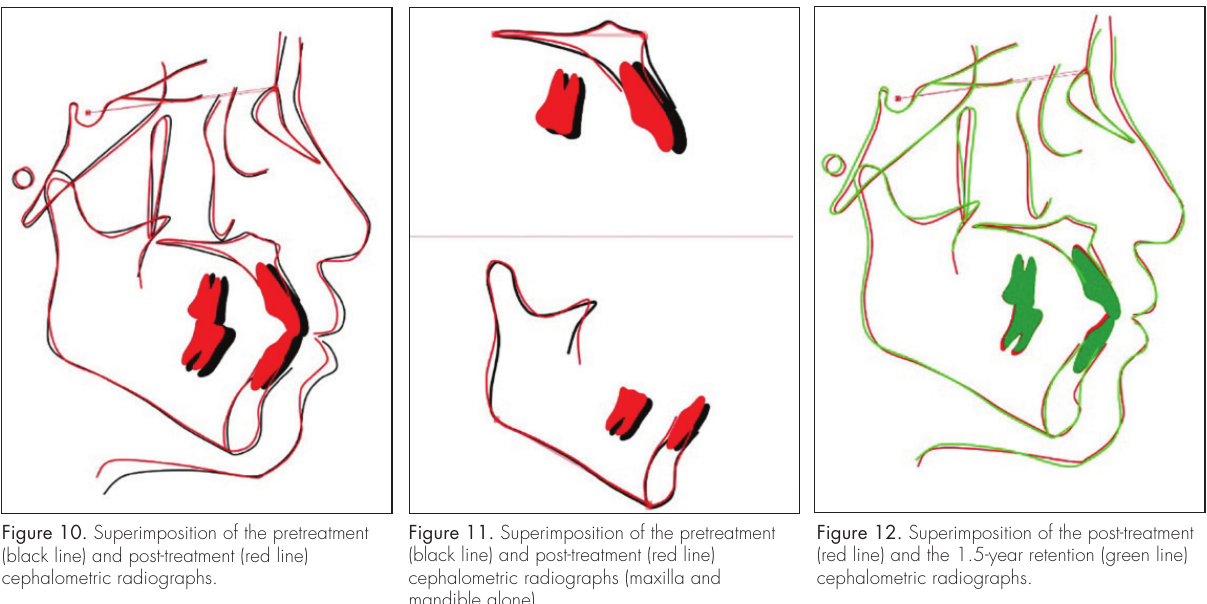
Figure 10. Superimposition of the pretreatment (black line) and post-treatment (red line) cephalometric radiographs.